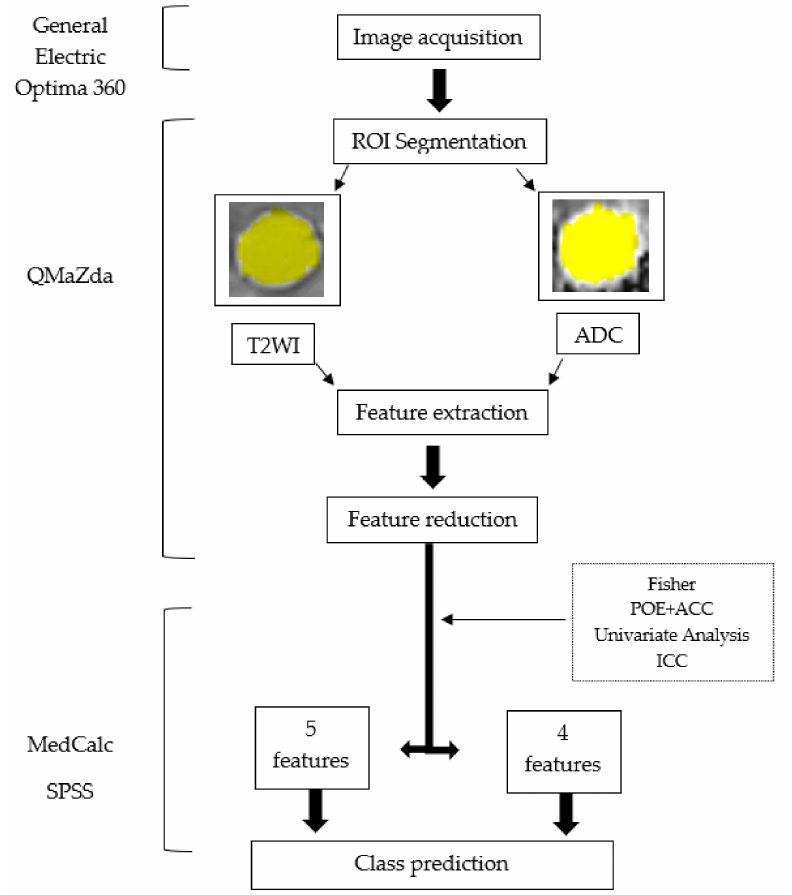
Figure 3. Radiomics workflow diagram. T2WI, T2-weighted images; ADC, apparent diffusion coeffi- cient; ROI, region of